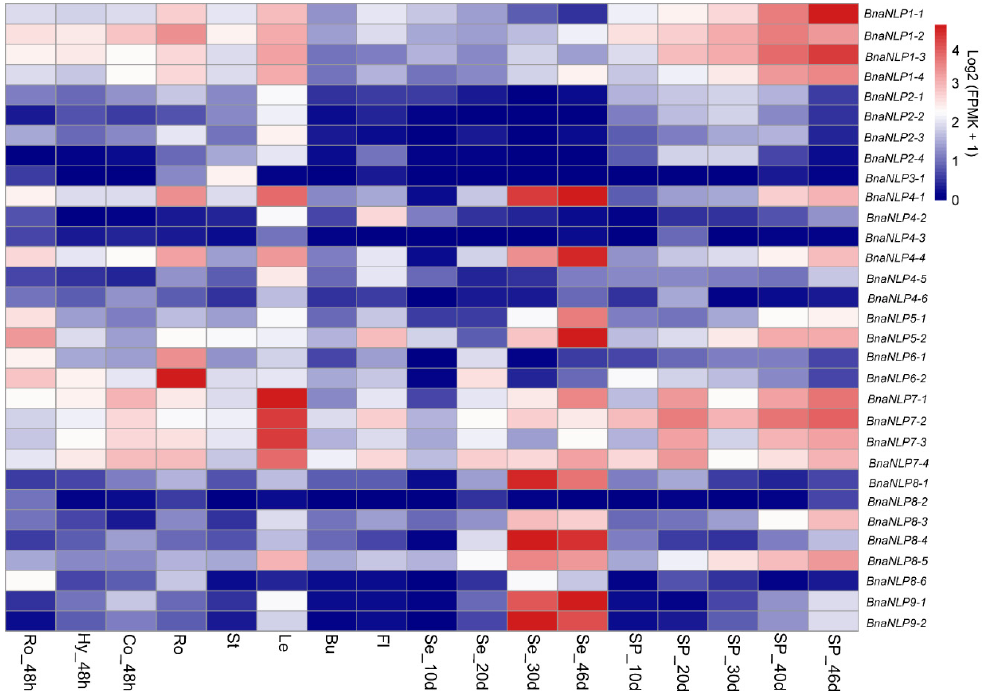
Figure 6. Organ-specific expression profiles of BnaNLP genes. Organ-specific expression patterns of BnaNLP genes were obtained based on the RNA-seq data. The color bar at the upper right side of the figure represents Log 2 (FPKM + 1), with blue representing little or no expression. Ro_48h: Roots collected at 48 h after germination; Hy_48: Hypocotyls harvested at 48 h after germination; Co_48h: cotyledons collected at 48 h after germination; Ro, St, Le, Bu and Fl: Roots, stems, leaves, buds and flowers harvested at the initial blooming stage; Se_10d, Se_20d, Se_40d and Se_46d: Seeds harvested at 10, 20, 40, and 46 days after flowering; SP_10d, SP_20d, SP_30d, SP_40d, and SP_46d: Silique pericarps harvested at 10, 20, 30, 40, and 46 days after flowering.